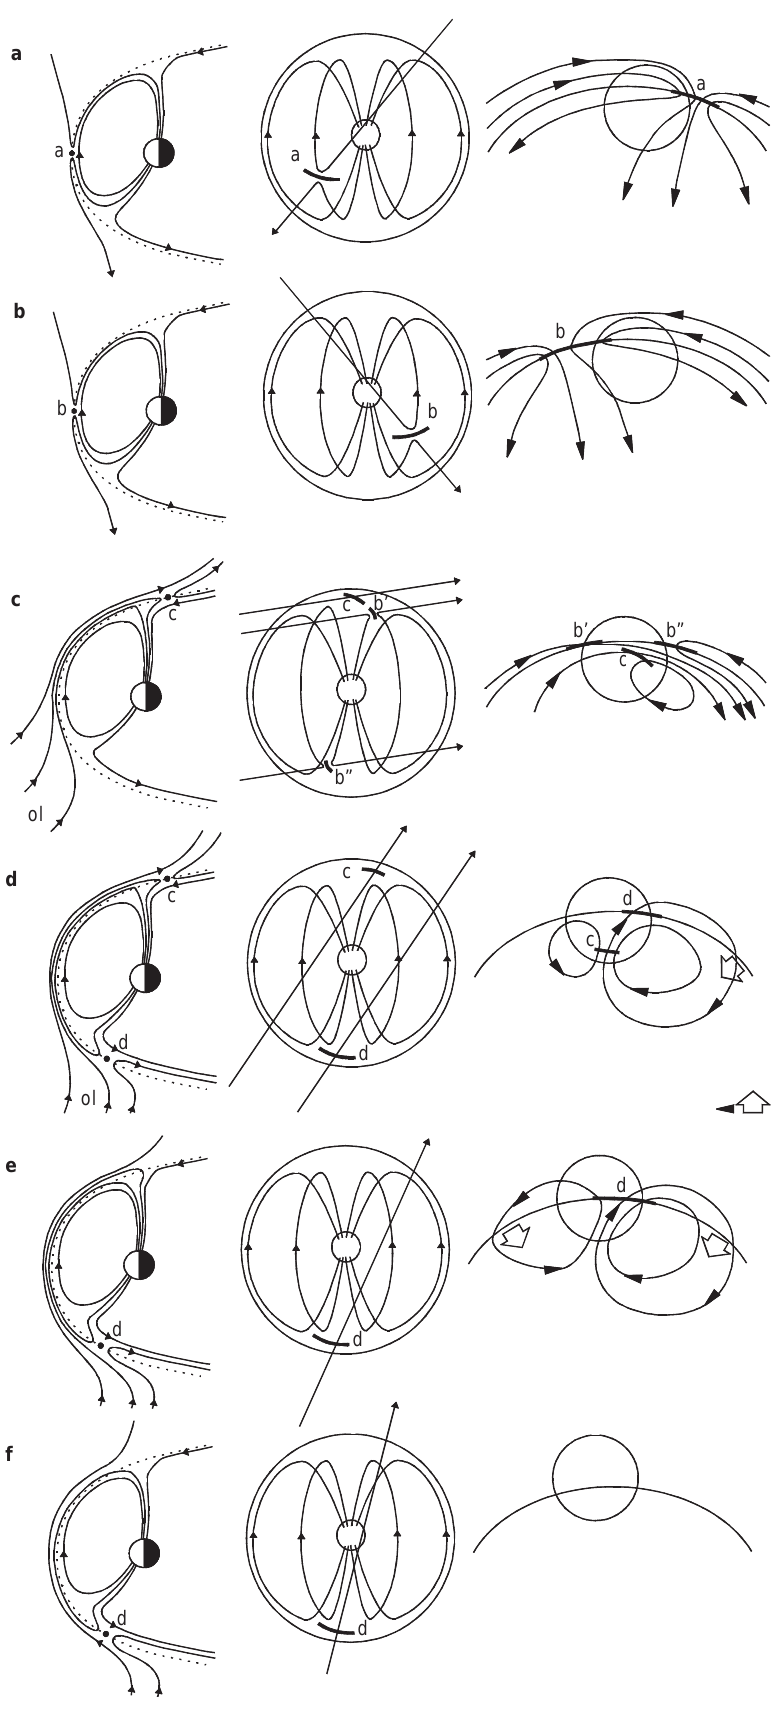
Fig. 7a–f. A series of schematics for a 08:25; b 08:40; c 09:00; d 09:07 (although, in fact this situation is unlikely to be present at all); e 09:10; f 09:14. The left hand plots are cross sections of the magnetosphere in a plane parallel to the XZ plane, viewed form dusk with the Sun to the left . The centre plots are views from the Sun and the right hand plots are views of the Northern Hemisphere ionosphere from above with noon to the top , dawn to the right and dusk to the left . Note that in the middle plots the lobe reconnection sites ( c and d ) are shown, but lobe and overdraped lobe field lines are omitted for clarity. Reconnection sites are labelled a, b, c and d and are dots in the left- hand figures and solid lines in the centre figures : their projections into the Northern Hemisphere ionosphere are solid lines in the right-hand figures . Lines with arrows are magnetic field lines in the left and centre figures, and flow stream lines in the right-hand figures . The circle shows the field-of- view of the 630 nm all-sky camera at